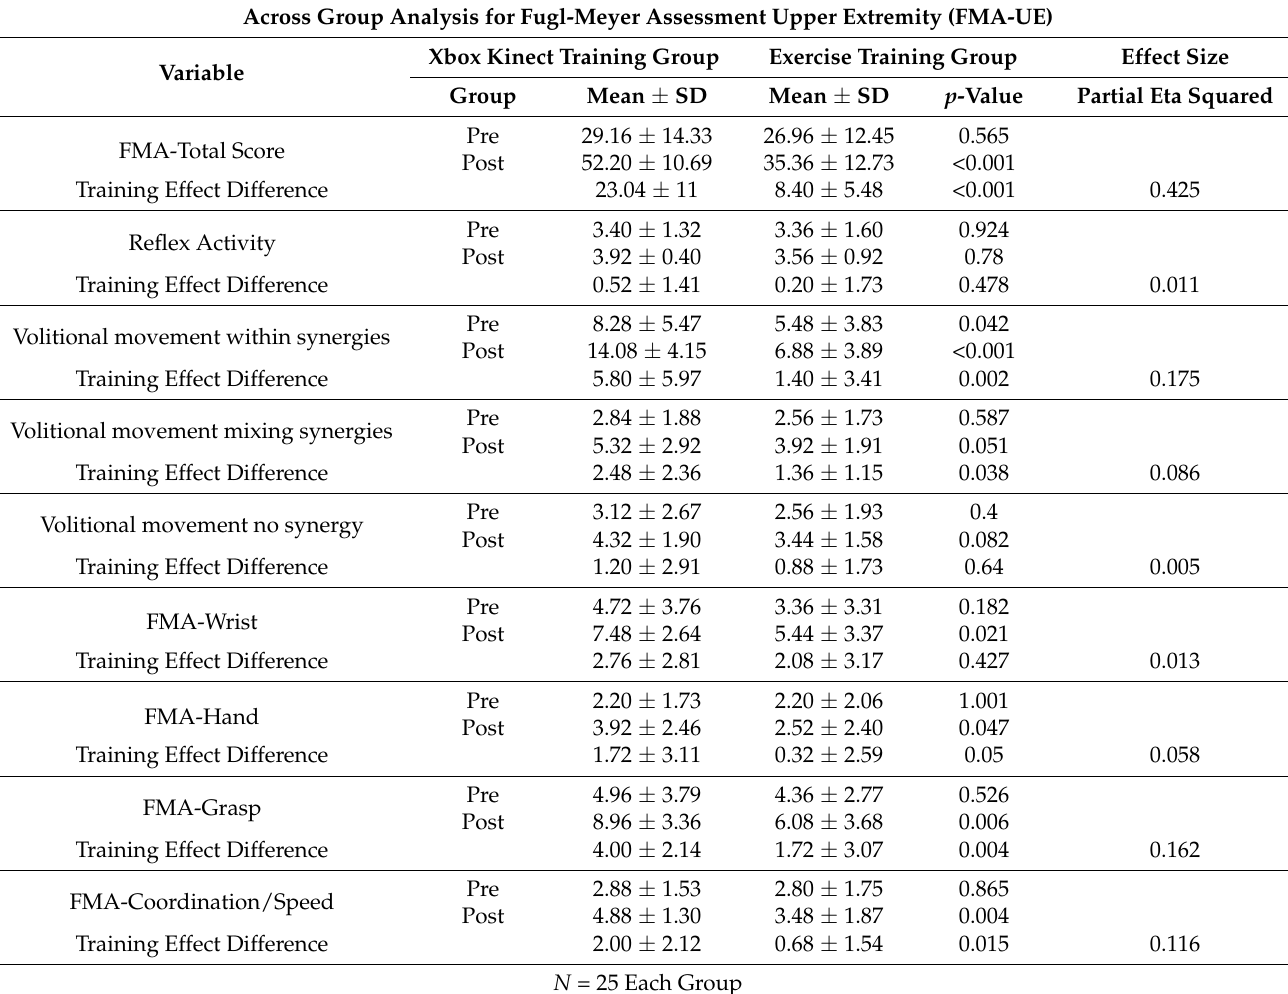
Table 2. Across group analysis for Fugl-Meyer Assessment Scale for Upper Extremity total score and each component. Across Group Analysis for Fugl-Meyer Assessment Upper Extremity